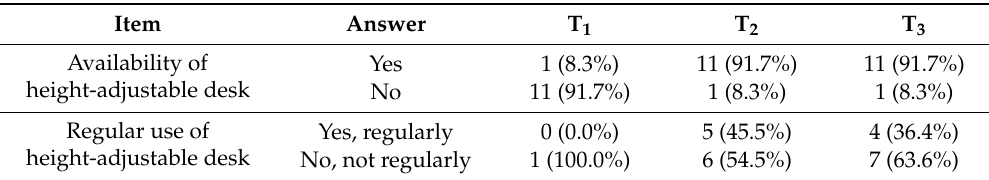
Table 3. Availability of height-adjustable desks and use of height-adjustable desks at baseline (pre-location (T 1 ), three months after relocation (T 2 ), and seven months after relocation (T 3